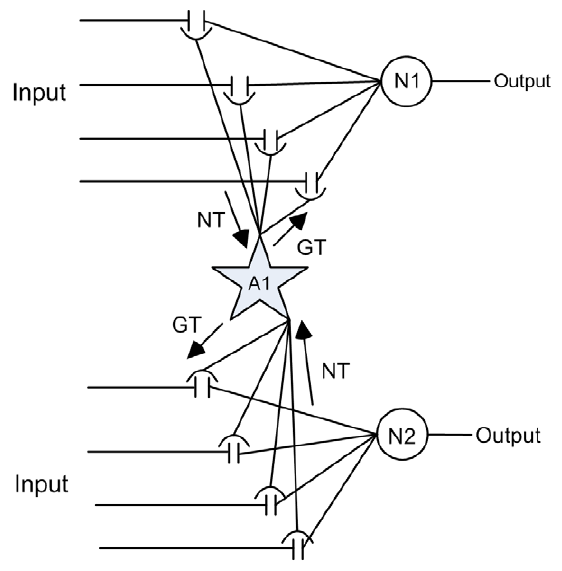
Figure 9. Dynamic coordination in the AN model. All synapses connected to the astrocyte can communicate via bidirectional signaling of neurotransmitter (NT) and gliotransmitter (GT).